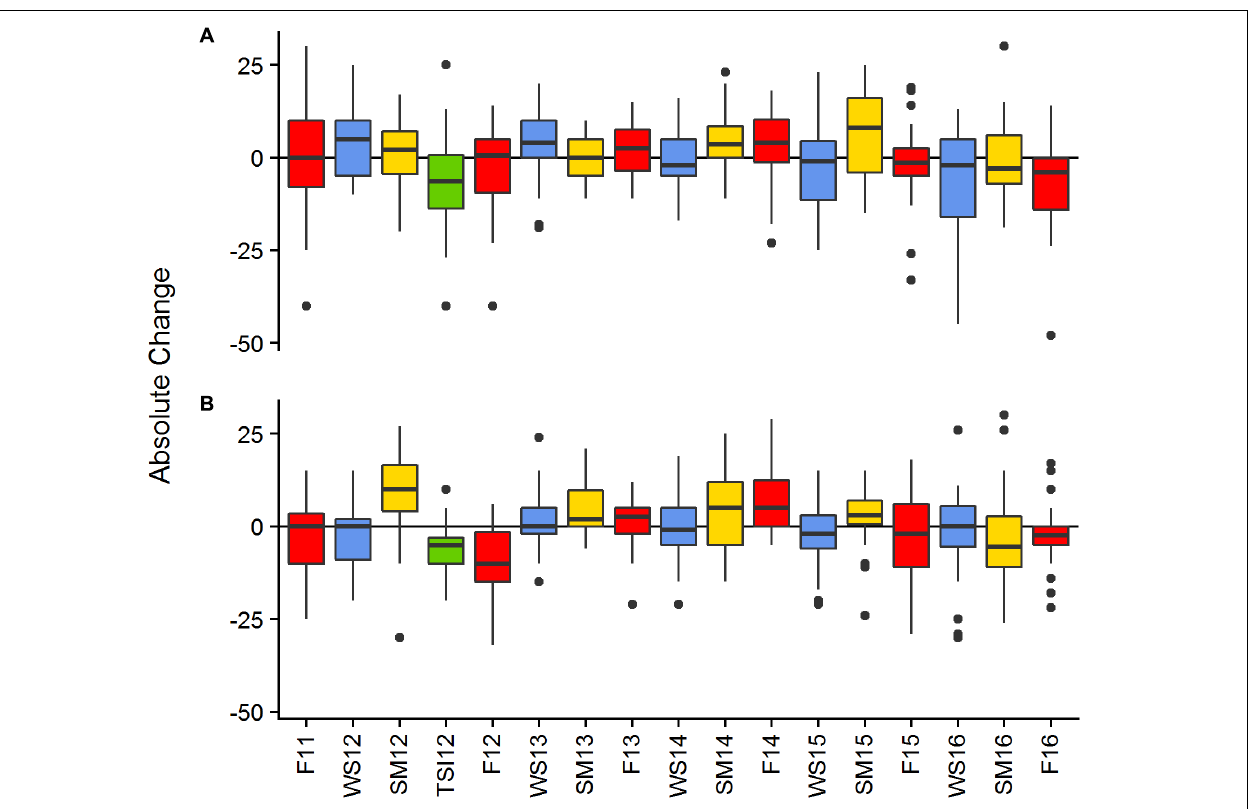
FIGURE 3 | Absolute change in canopy height between monitoring events of living Acropora cervicornis by site BCA (A) , Scooter (B) . Colors represent seasonal changes from Fall to Winter—blue, Winter to Summer—yellow, and Summer to Fall—red, the green bar represents change in cover between the SM12 and the TSI12 monitoring events. Boxes represent the 25 and 75% quartiles with whiskers extending 1.5 ∗ interquartile range, the line represents the median, and dots are considered outliers.